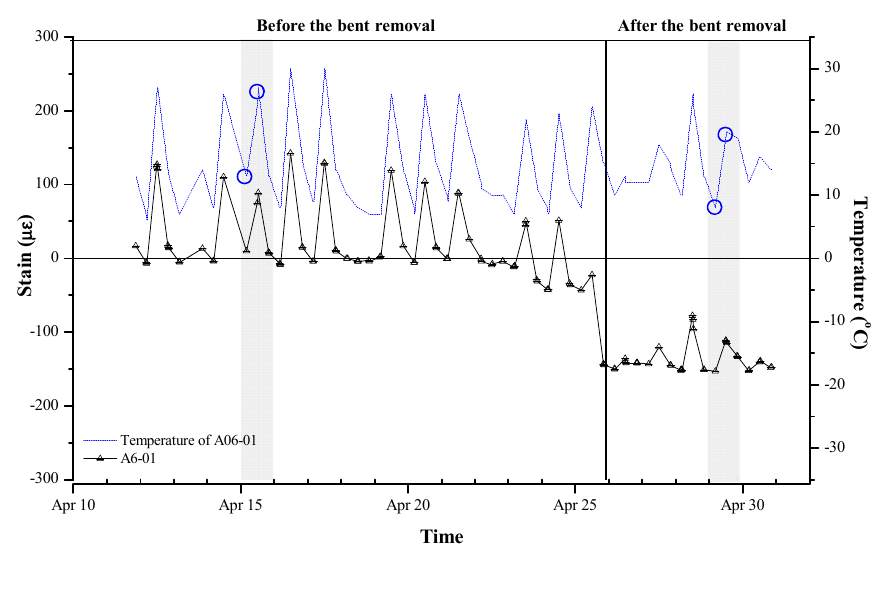
Figure 11. Relationship between temperature and strain